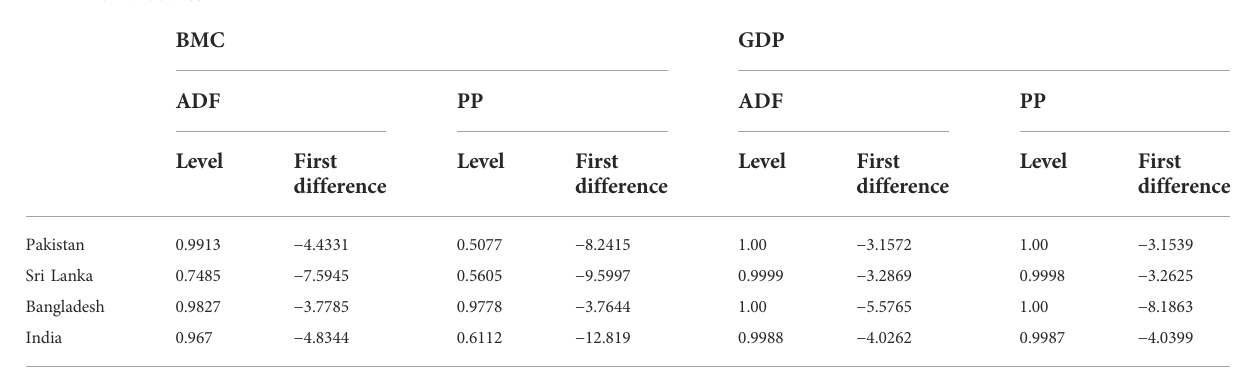
TABLE 1 Unit root test.